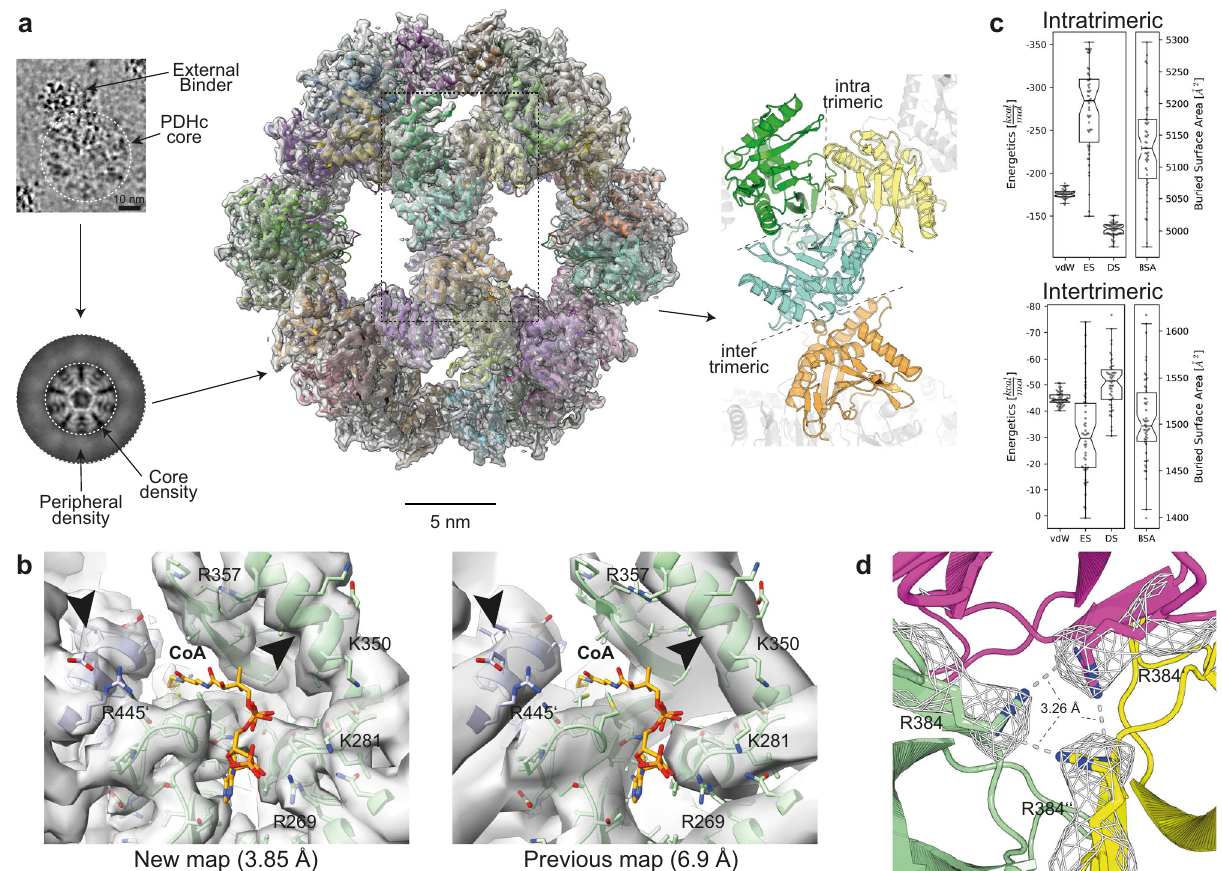
Fig. 2 Near atomic resolution reconstruction and characterization of the PDHc core. a Icosahedrally-averaged cryo-EM reconstruction of PDHc core. Densities corresponding to PDHc higher-order binders, visible in raw micrographs (scale bar represents 10 nm), as well as external PDHc densities of the metabolon, visible in 2D classes, are averaged to retrieve the high-resolution core structure. Each E2 monomer is colored uniquely. b Comparison of improvement in resolution, compared to previous data 21 . CoA molecule is not resolved but is here computationally placed and re fi ned within the binding site as described in the Methods section. Sidechains in the CoA binding pocket of the active site are distinguishable. Helical pitch (arrowhead) allows now the unambiguous placement of the backbone. c Energetic calculations within the E2 core structure from n = 50 HADDOCK models. The intra-trimeric building block with an extensive buried surface area (BSA) is stabilized by electrostatics (ES) and van der Waals (vdW) energies, whereas desolvation energies (DS) have a minor contribution. In the dimeric inter-trimeric interaction, DS energy plays a major role, whereas vdW and ES energies have decreasing contributions. The box minima represent the 25th percentile, the box maxima the 75th percentile, the Notch indicated the data ’ s median, whiskers extend to the minimum and maximum value inside of a 1.5 interquartile range. All data points are overlayed as a beeswarm plot. d Potential Arginine cluster in the intra-trimeric interface. Arg384 of each subunit are in close contact, thereby contributing to the electrostatic binding energy. Contour levels applied for the cryo-EM maps are as follows: a 0.05, b 0.041, c 0.03 (new map) and 0.09 (old